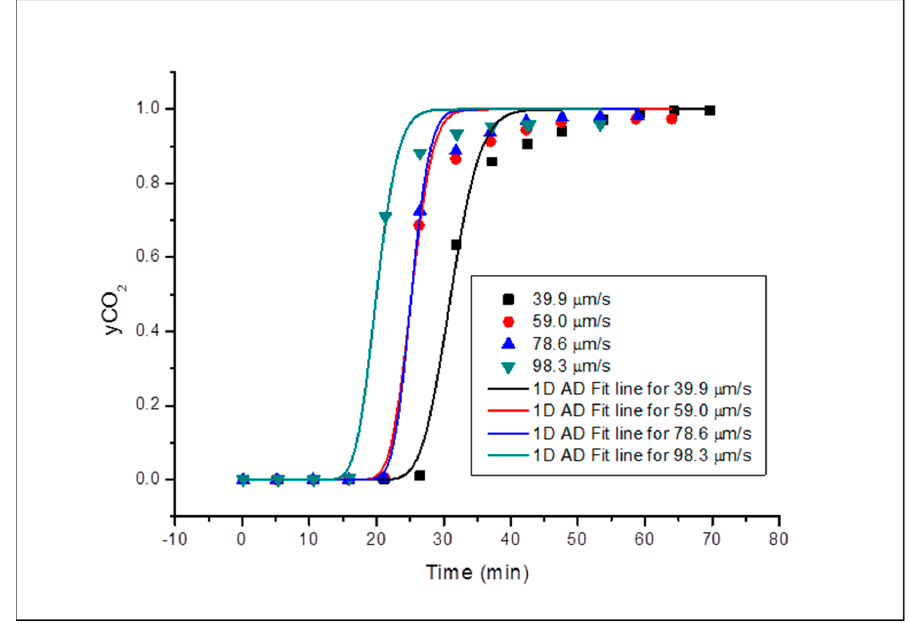
Figure 7. Concentration profile for Bandera Grey in horizontal orientation.